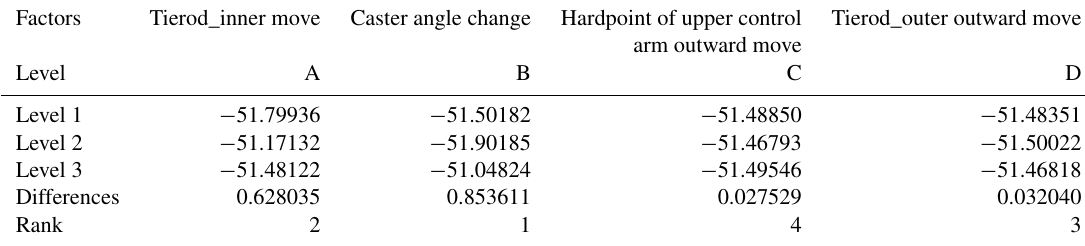
Table 12. SN ratio of first parameter combination for the Taguchi experiment (turning radius).